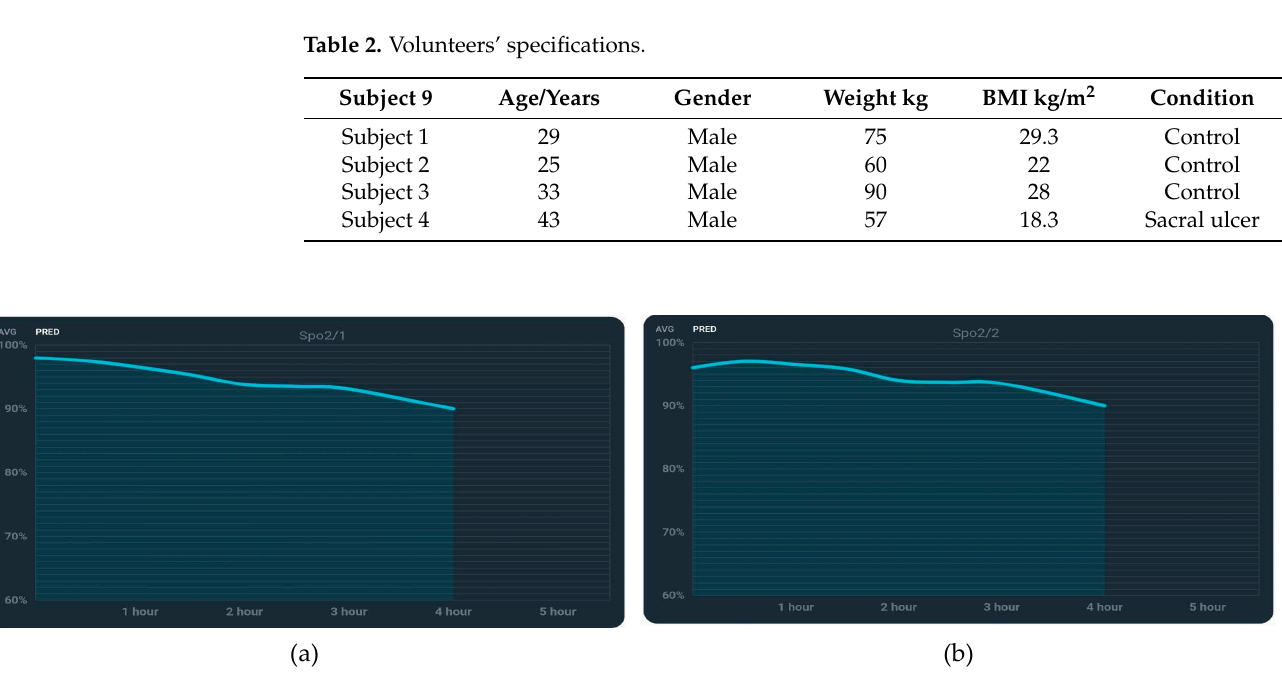
Figure 10. SpO2 measurements: ( a ) from location B1, and ( b ) from location B2.